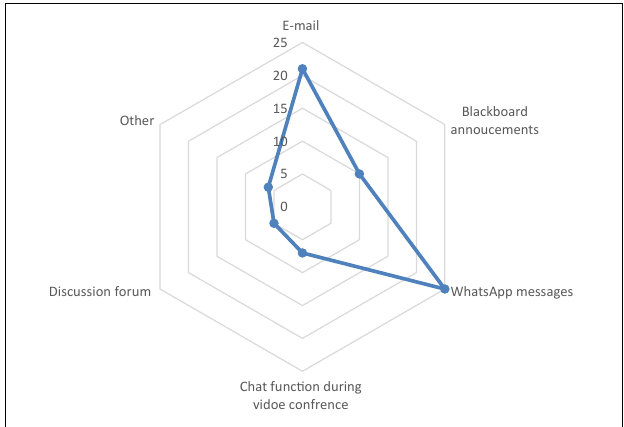
FIGURE 4 | Students’ preference of different modes of